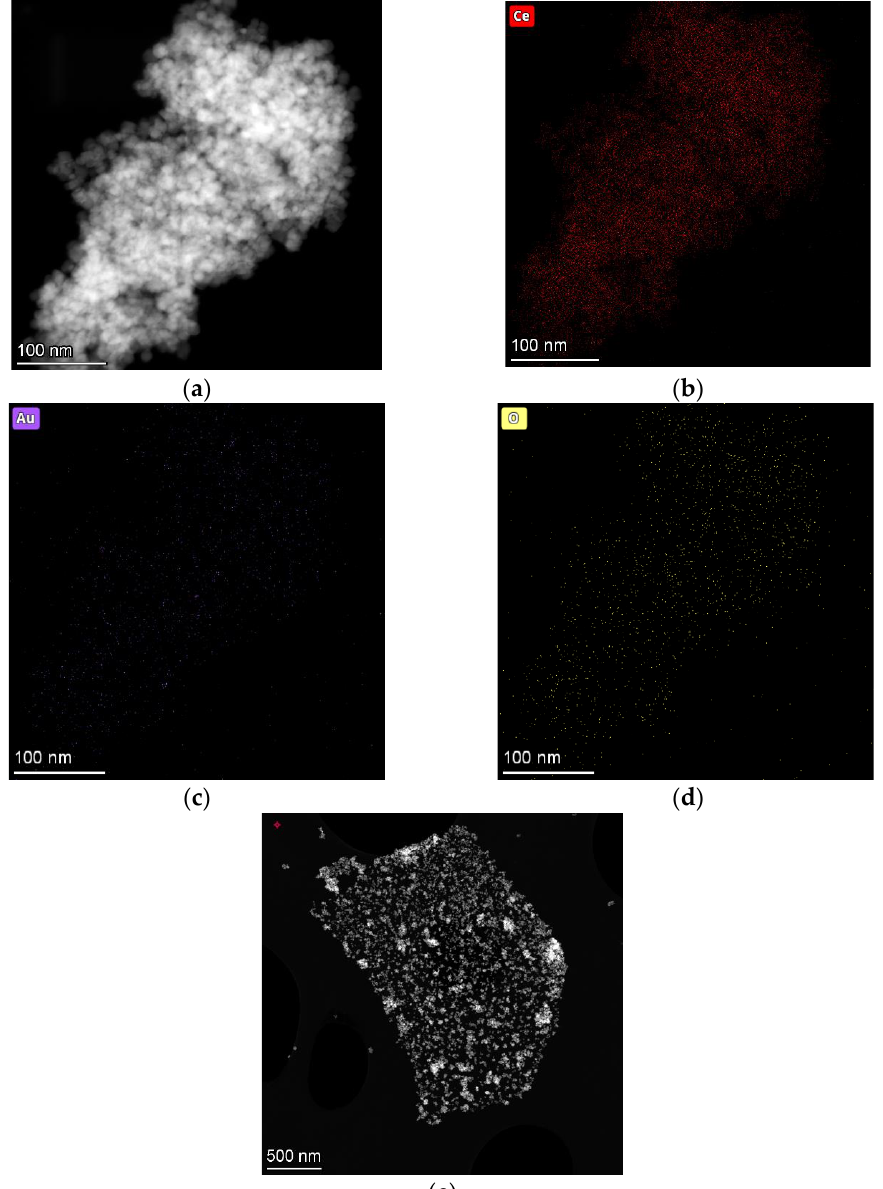
Figure 6 . STEM micrograph of ( a ) CeO 2 -rGO-Au sample and its elemental mapping; ( b ) Ce; ( c ) Au and ( d ) O. Panel ( e ) is a micrograph in which it is evident how the CeO 2 -Au nanoparticles are deposited in a GO sheet distinguishable for the delineated edges.